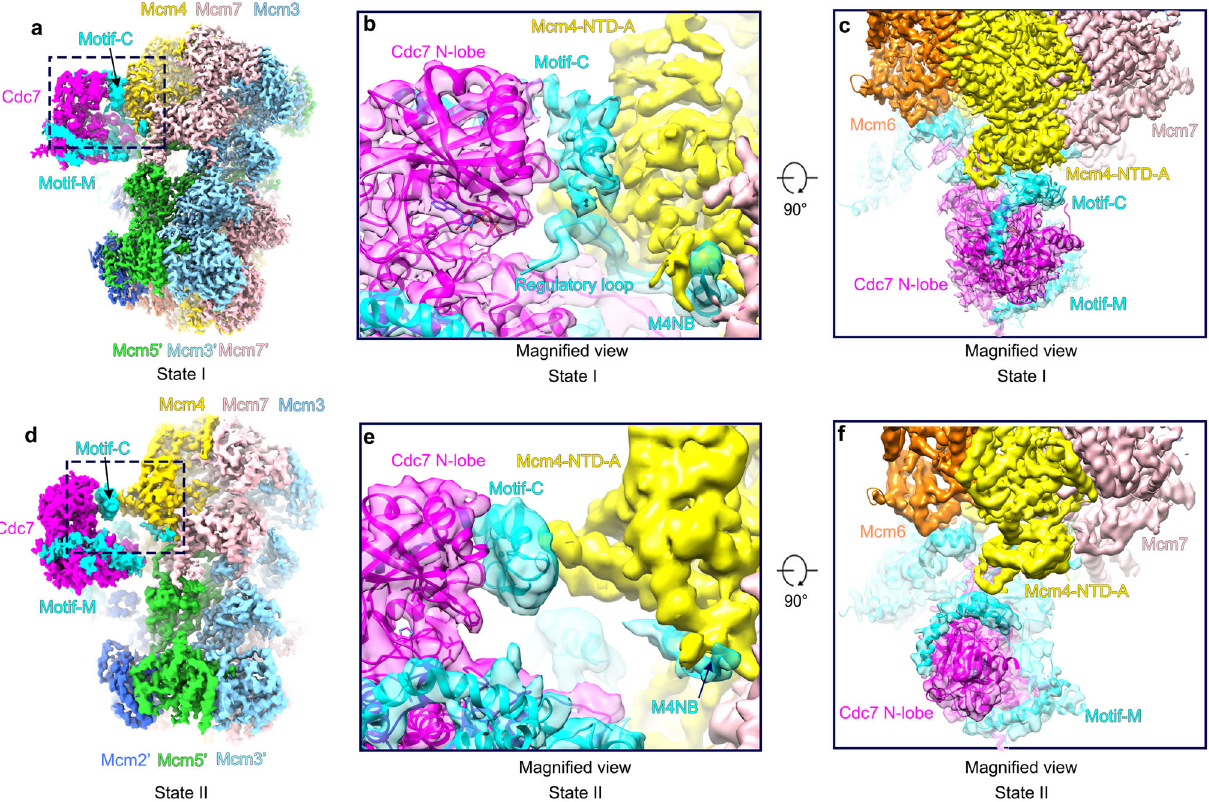
Fig. 4 Conformational change of kinase core relative to the NTD-A of Mcm4. a Side view of the cryo-EM density map of the DH-DDK complex (State I). b Magni fi ed view of the boxed region in ( a ), highlighting the kinase core of DDK bound to the NTD-A of Mcm4 via motif C of Dbf4. c Same as ( a ) but with a 90° rotation and shown in top view with a focus on Mcm4 and DDK. d – f Same as ( a – c ) but shown in State II of the DH-DDK